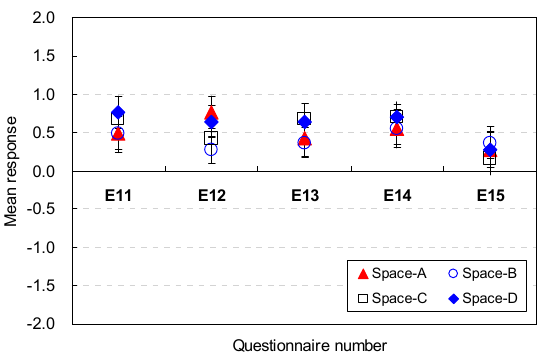
Figure 16. Spatial perception of the spatial configuration in terms of efficiency under height changes.